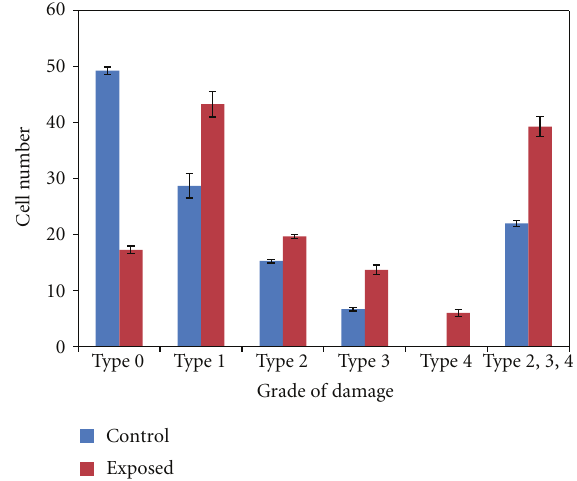
Figure 4: The level of DNA damage in brain cells of control newborn rats and those exposed to 50 Hz and 0.5 mT MF for 30 days 24 h/day. Assessed by comet assay. Mean ± S.E. ( P < 0 . 05).